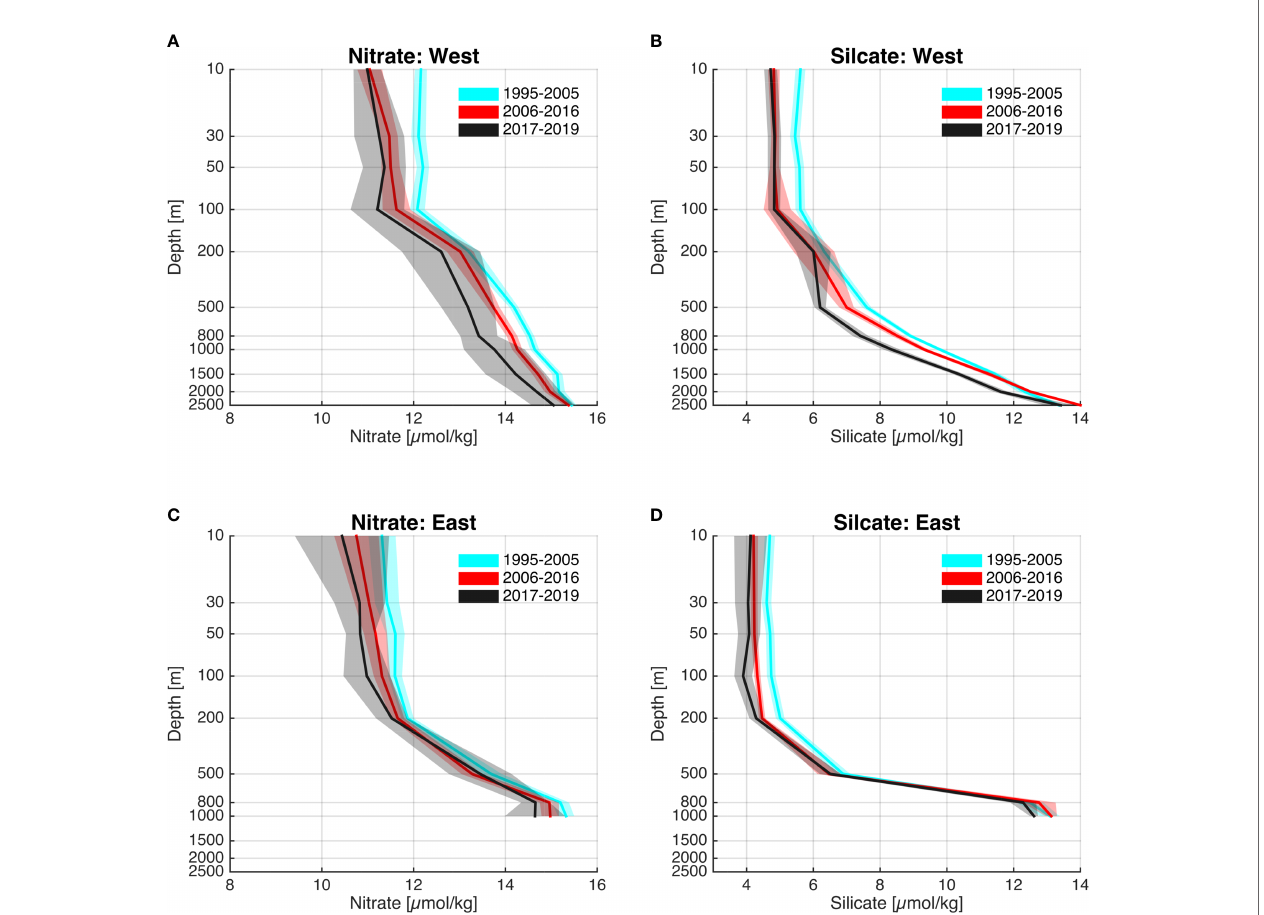
FIGURE 7 | (A – D) Time-mean depth pro fi les of nutrients in the Svinøy section showing (A) nitrate, and (B) silicate from the stations 1-3, and (C) nitrate and (D) silicate from the stations 9-11. The legend shows the periods 1995-2005 (magenta), 2006-2016 (red), and 2017-2019 (black). Data are from months January-March. The shaded areas show the 95% con fi dence interval. The positions of the stations are indicated in Figure 4A